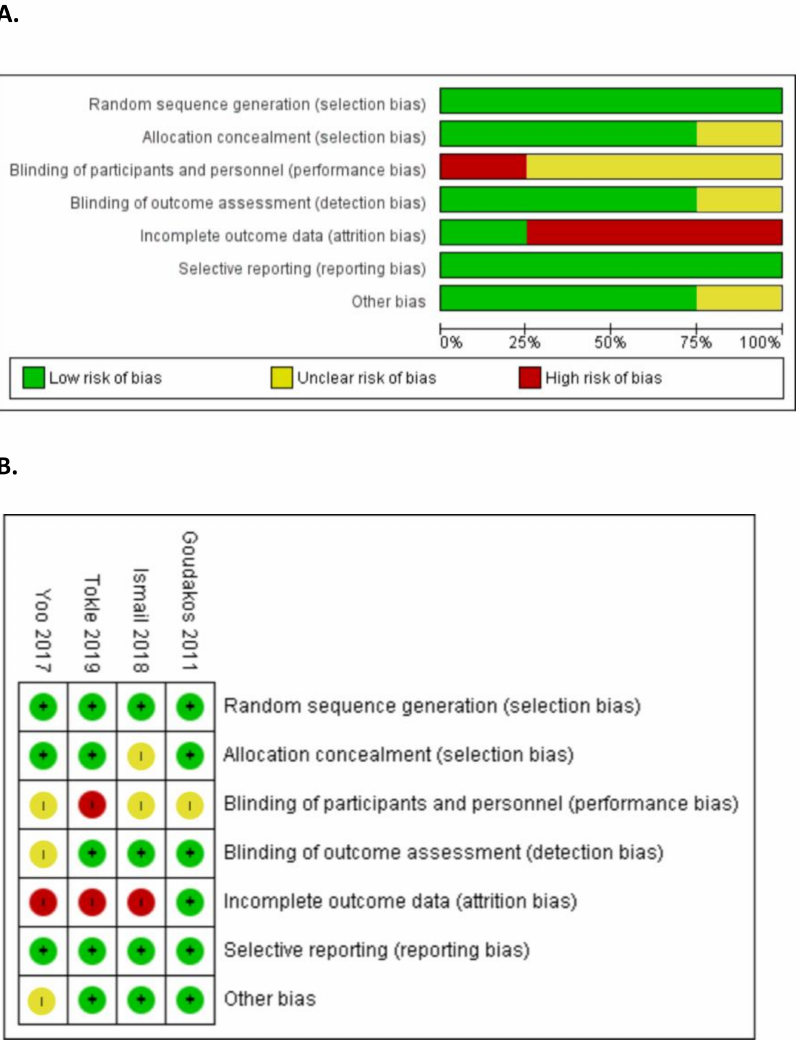
Figure 2. Risk of bias analysis results. ( A ) Risk of bias summary: review authors’ judgments about each risk of bias item for each included study. ( B ) Risk of bias graph: review authors’ judgments about each risk of bias item presented as percentages across all included studies